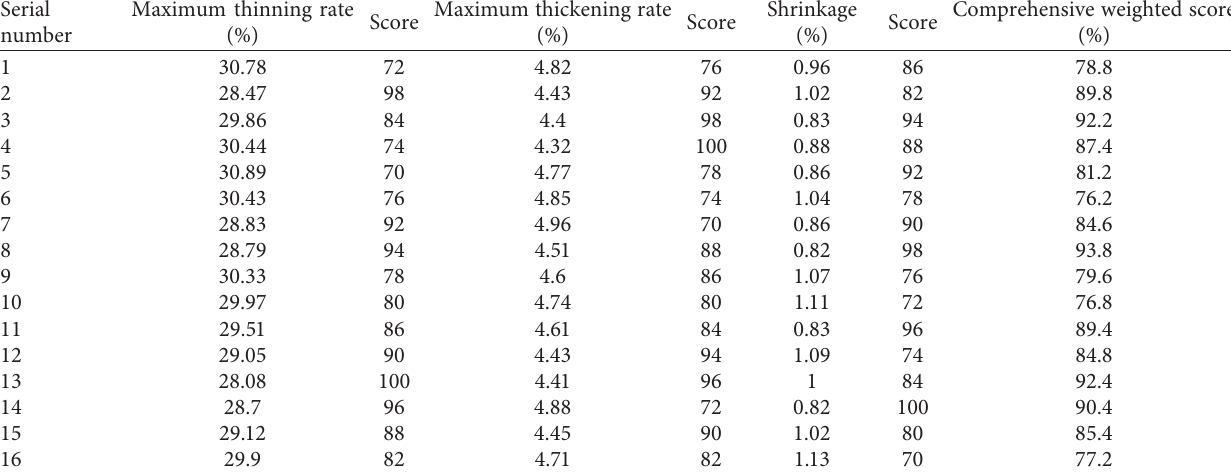
Table 6: Comprehensive scoring results of compression molding of trunk trim